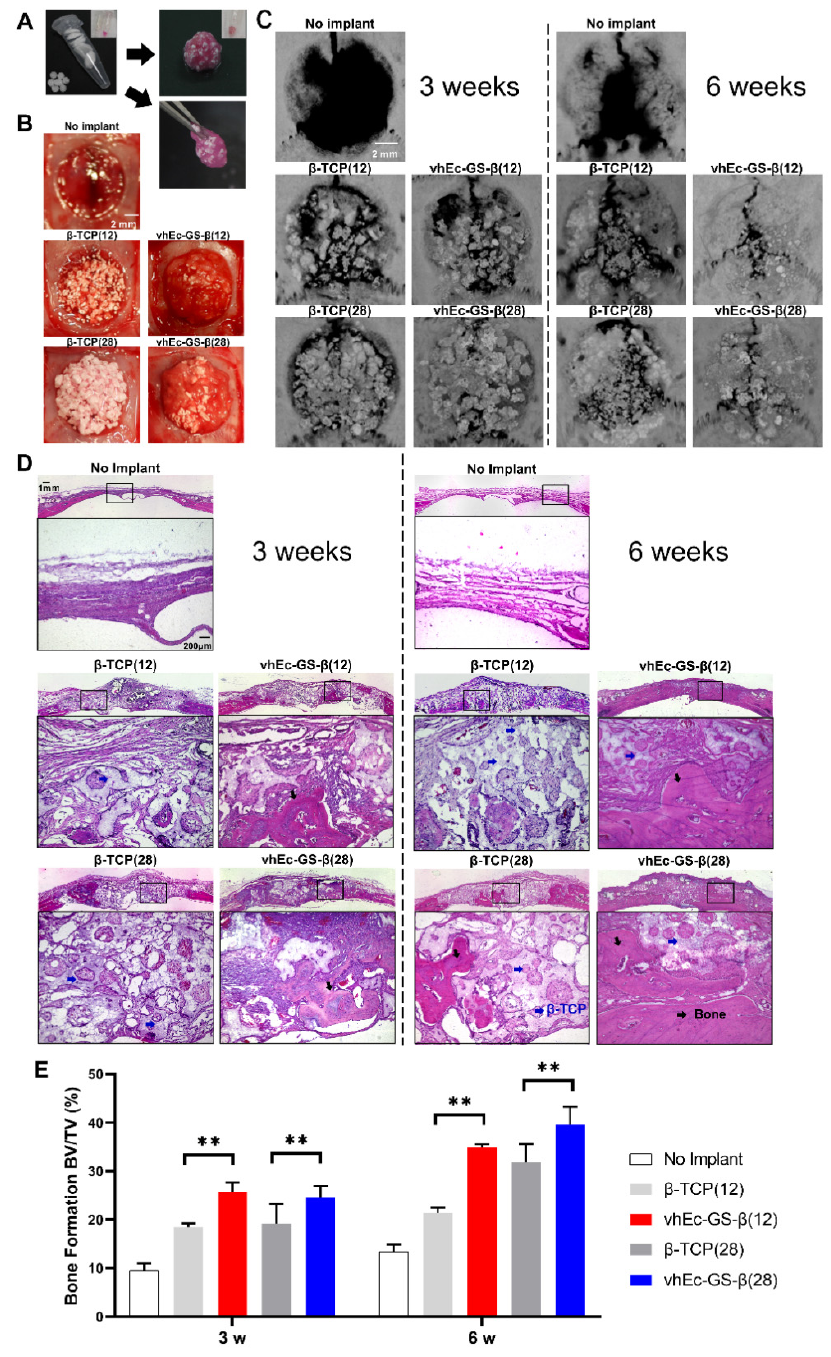
Figure 6. Animal experiments to evaluate bone formation. ( A ) Preparation of the hydrogels: seven pieces of sponges for each hydrogel. ( B ) Macroscopic images of bone defects and those treated with materials right after the surgery ( n = 4). ( C ) Microcomputed tomography ( µ -CT) images of bone defects at three and six weeks. ( D ) Hematoxylin and eosin (H&E) staining of bone defects. ( E ) Quantitative µ -CT analysis after the removal of β -TCP granules. Statistical significance: comparison between granules and hydrogels is presented as follows: ** p < 0.01. BV/TV: bone volume per total volume (%).